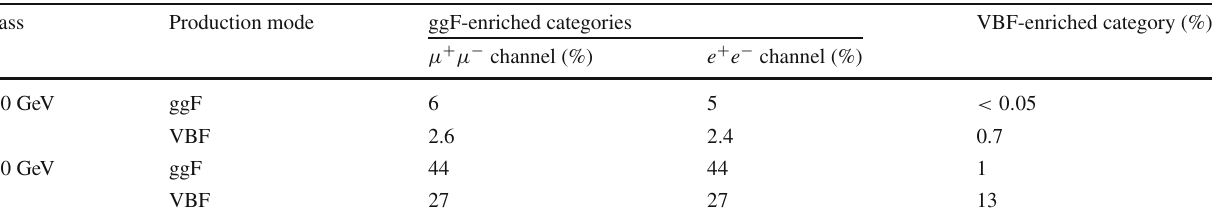
Table 2 Signal acceptance for the (cid:3) + (cid:3) − ν ¯ ν analysis, for both the ggF and VBF production modes and resonance masses of 300 and 600 GeV. The acceptance is defined as the ratio of the number of